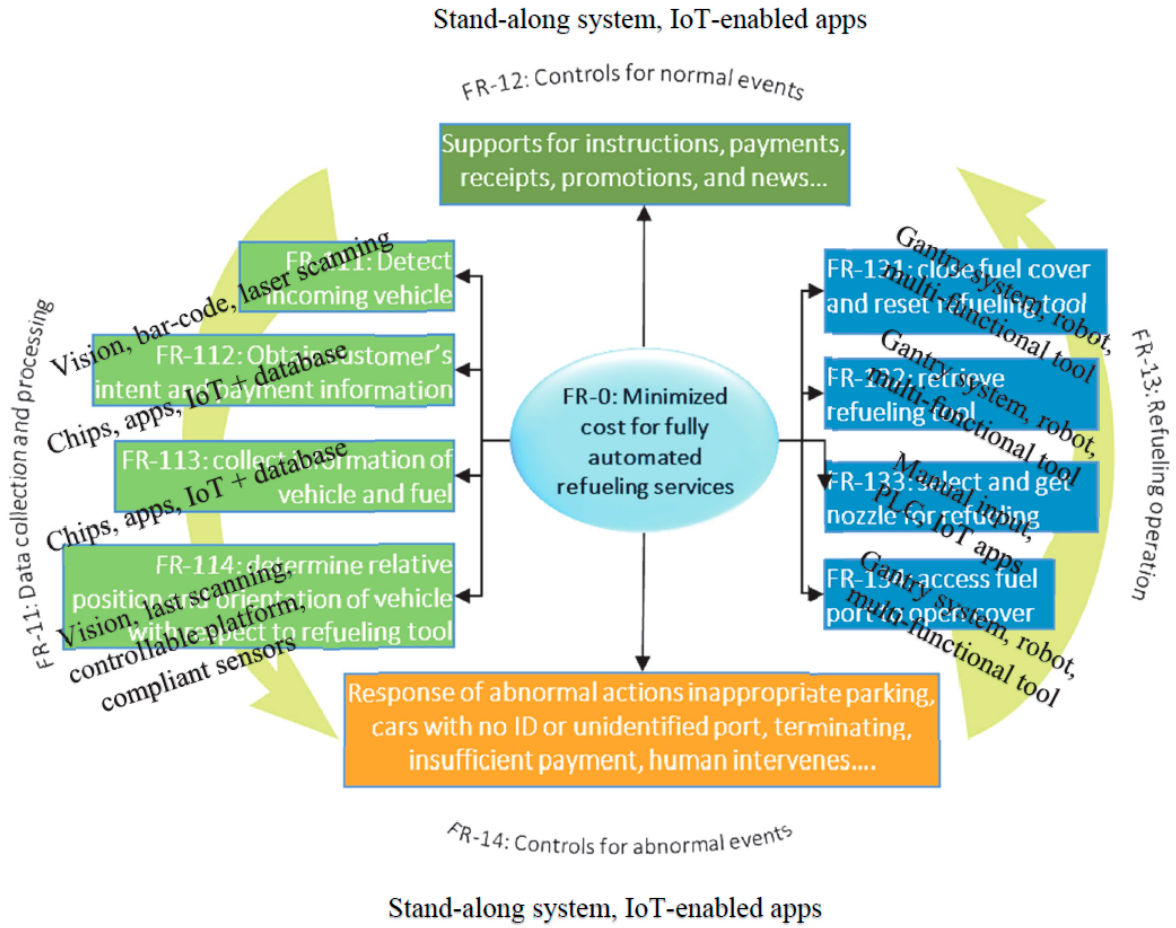
Figure 5. Design solutions (DSs) to fully automated refueling (Reprinted with permission from ref. [5]. 2021 Emerald Publishing Limited).